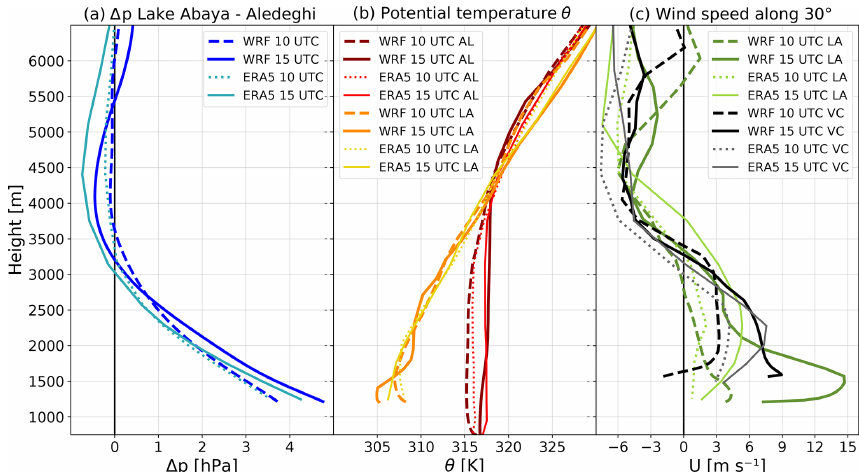
Figure 8. As in Fig. 4 but for 10:00 and 15:00UTC 5 June 2018. The pressure difference (cid:49)p is calculated as the pressure at Lake Abaya (LA) minus the pressure at Aledeghi (AL; Fig. 1b). The wind profiles for Lake Abaya and the along-valley centre (VC) in (c) refer to the wind component in an azimuth direction of 30 ◦ , i.e. along the valley in a north-easterly